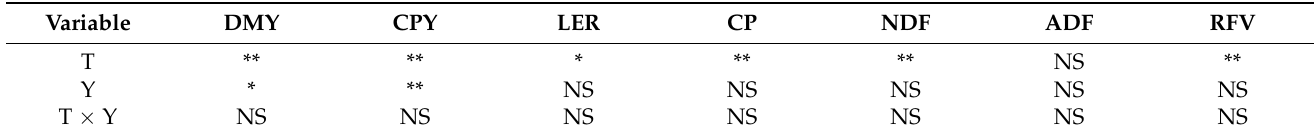
Table 4. ANOVA for the effects of treatments (T), years (Y), and their interactions (T × Y) on total dry matter yield (DMY), crude protein yield (CPY), land equivalent ratio (LER), crude protein (CP), neutral detergent fiber (NDF), acid detergent fiber (ADF), and relative feed value (RFV).